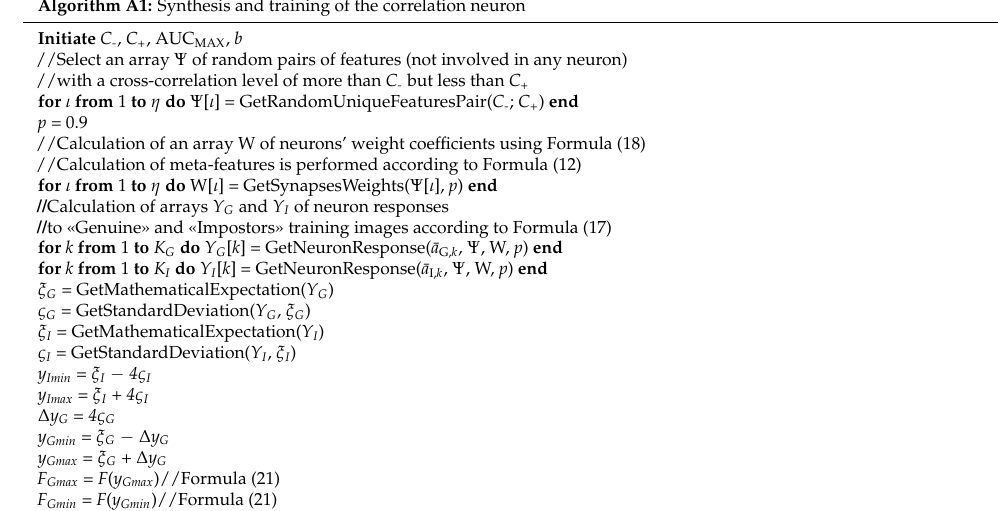
Algorithm A1: Synthesis and training of the correlation